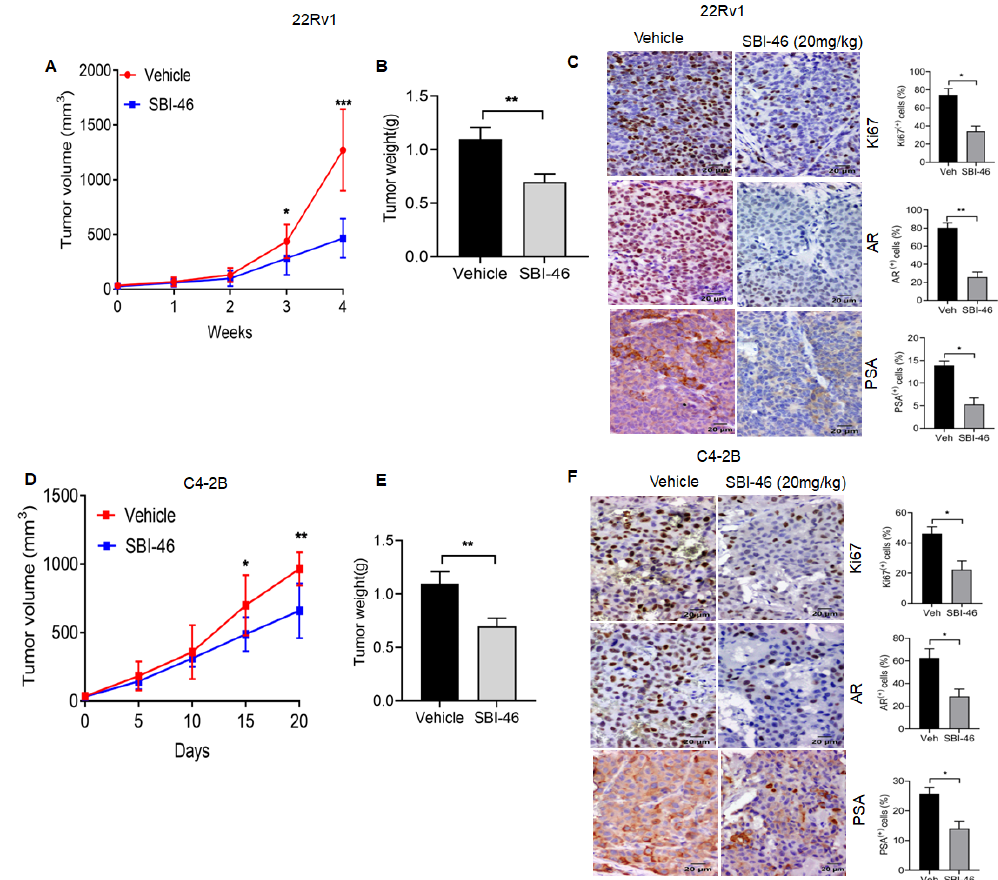
Figure 5. SBI-46 potently suppresses PCa xenografts tumor growth in nude mice. ( A , D ) Tumor growth curves for subcutaneous 22Rv1 and C4-2B xenograft nude mice model: nude mice bearing 22Rv1 and C4-2B xenograft tumors ( n = 6) were treated with either vehicle or SBI-46 (20 mg/kg, Orally), for five days/week for four weeks. ( B , E ) Tumor weight of SBI-46- or vehicle-treated 22Rv1 and C4-2B mice xenografts. ( C , F ) Representative images of Ki67, AR, and PSA immunostaining were performed in SBI-46- or vehicle-treated mice (22Rv1 and C4-2B) xenografted tumor samples. The p -values corresponding to various symbols used are: * p < 0.05; and ** p < 0.01.